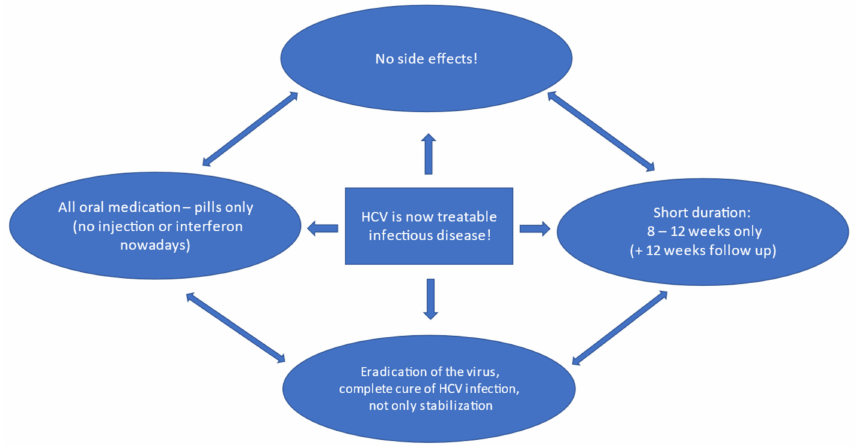
Figure 3. Viral hepatitis C treatment with DAA—key information to share with professionals from other fields as well as with potential